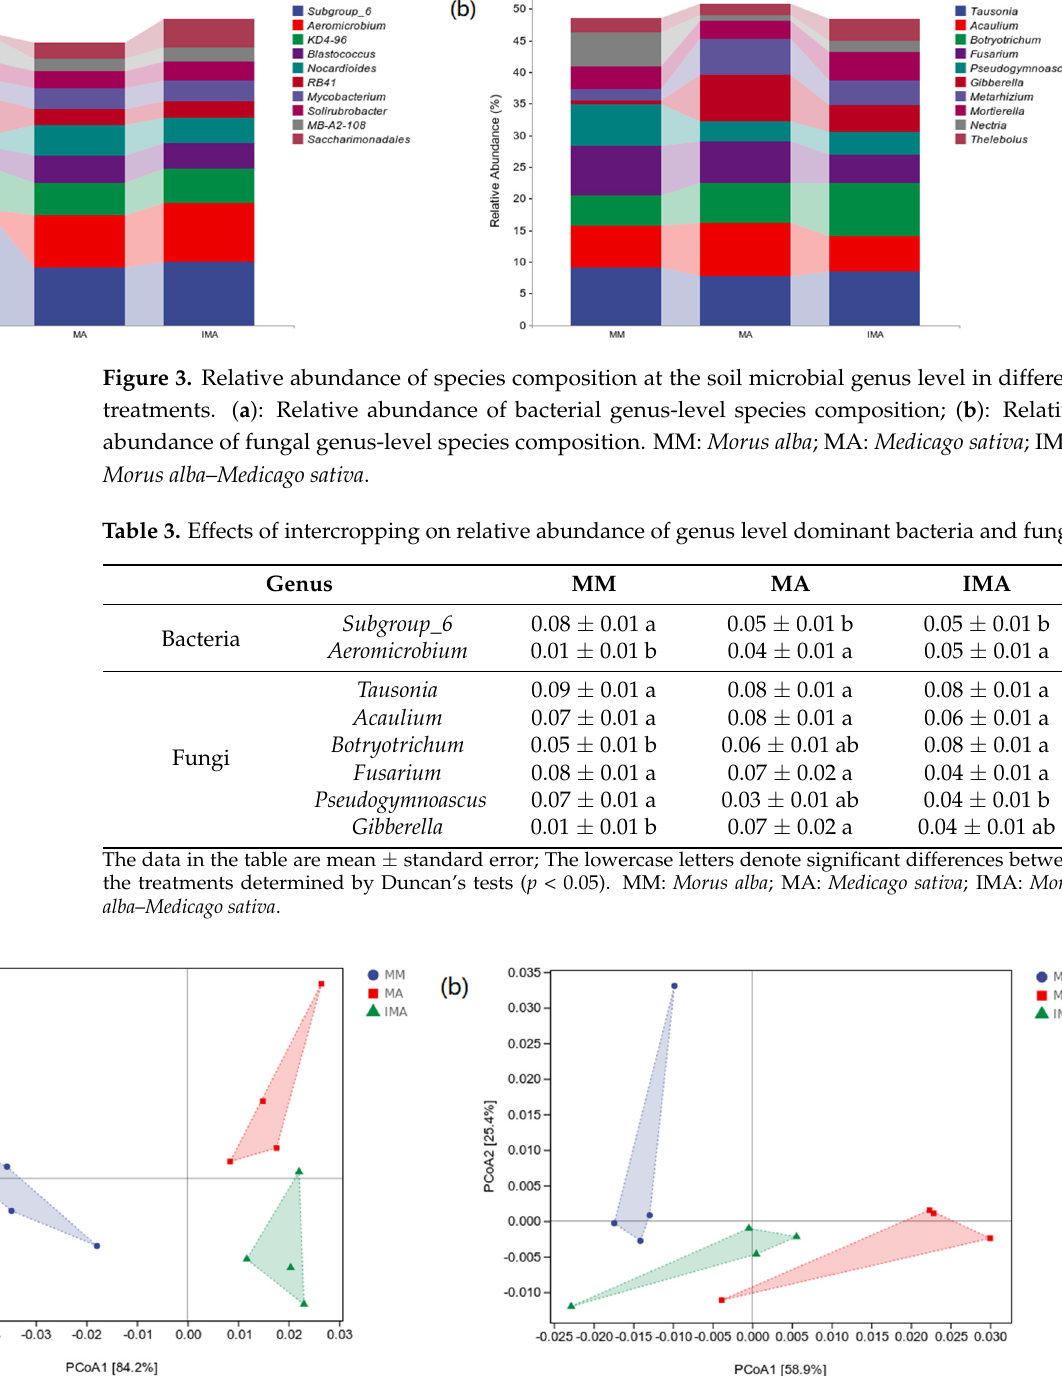
Figure 4. Principal coordinates analysis of potential functions of soil microorganisms under different treatments. Principal coordinates analysis plot based on the Bray–Curtis distance. ( a ): soil bacterial communities; ( b ): soil fungal communities. MM: Morus alba ; MA: Medicago sativa ; IMA: Morus alba – Medicago sativa .